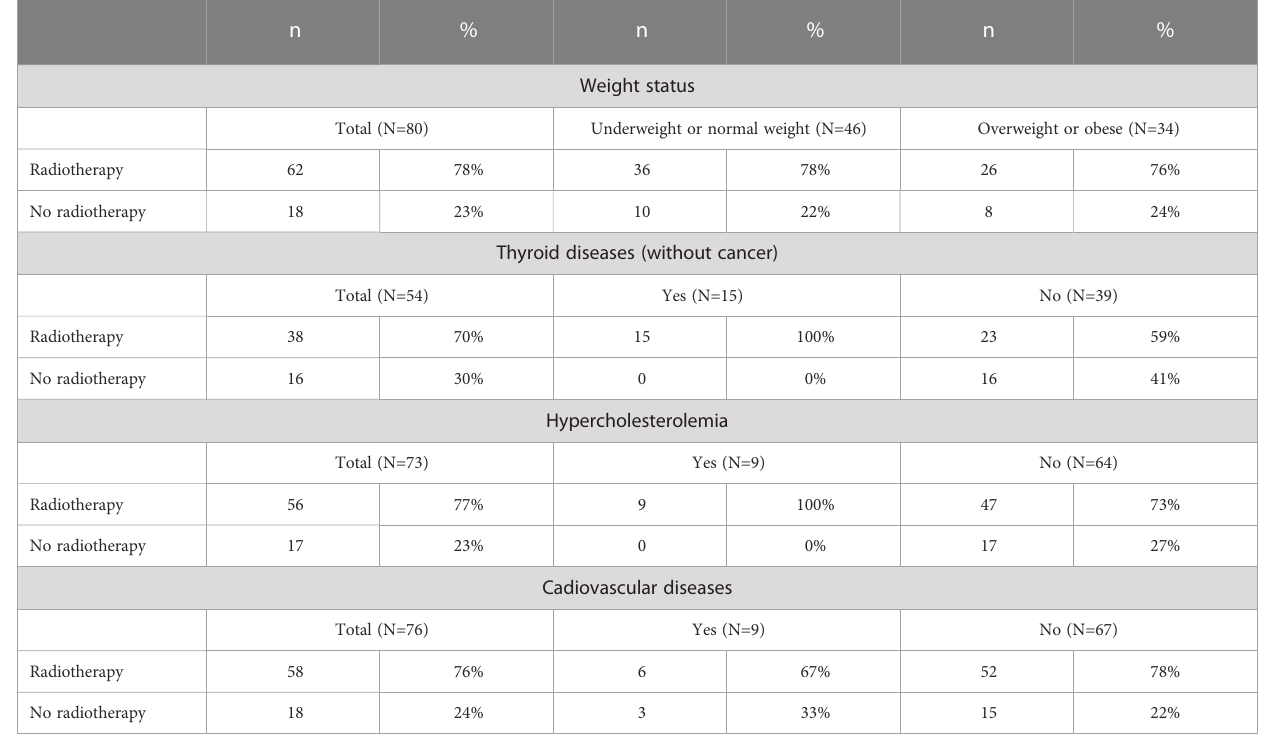
TABLE 6 Self-reported exposure to radiotherapy and late adverse health effects in CCS of SPN from the KiKme case-control study.